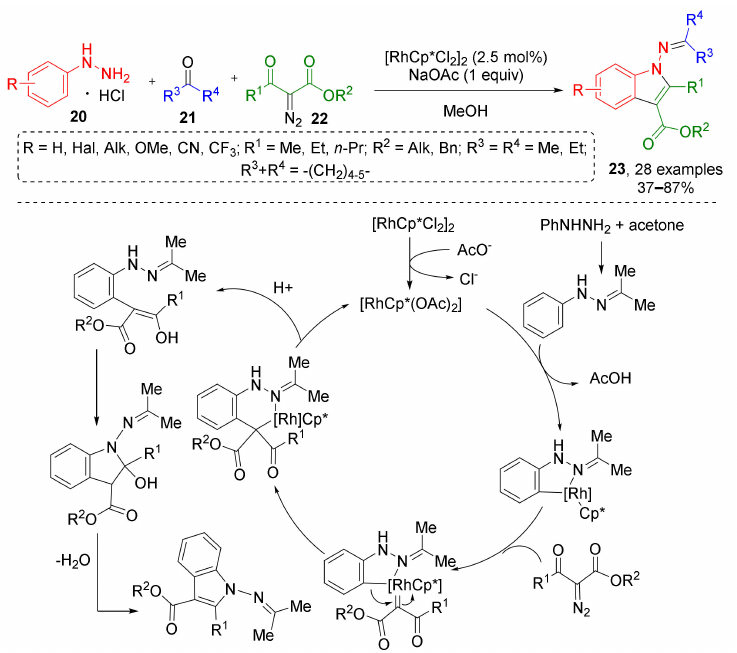
Scheme 6. Synthesis of 1-iminoindoles via Rh(III)-catalyzed three-component